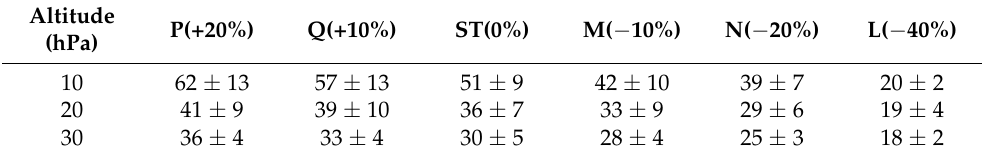
Values are averaged between 10 ◦ S and 10 ◦ N, and unit is 10 − 5 ms − 1 . Interannual variations are evaluated from detrended